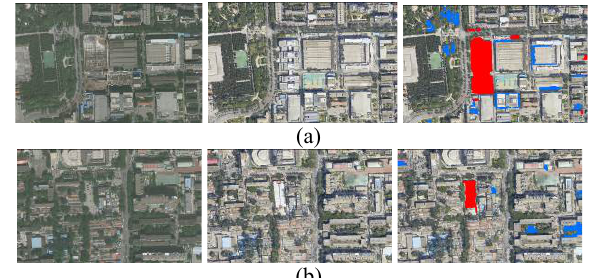
Figure 9. Low-rise building missing change patch cases. (a) TDOM of 2015 and 2017, single building patch extracted by change detection, but missed by visual interpretation, (b) TDOM of 2015 and 2017, storey increases change patch extracted by change detection, but unidentified by visual